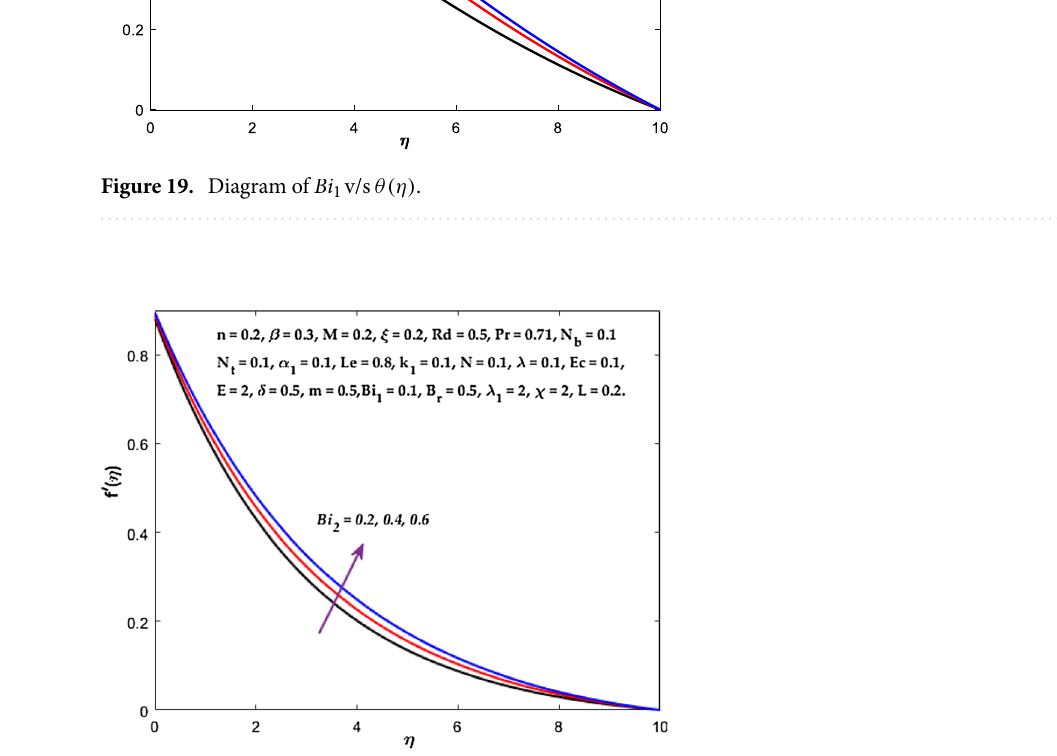
Figure 20. Diagram of Bi 2 v/s f ′ (η) .